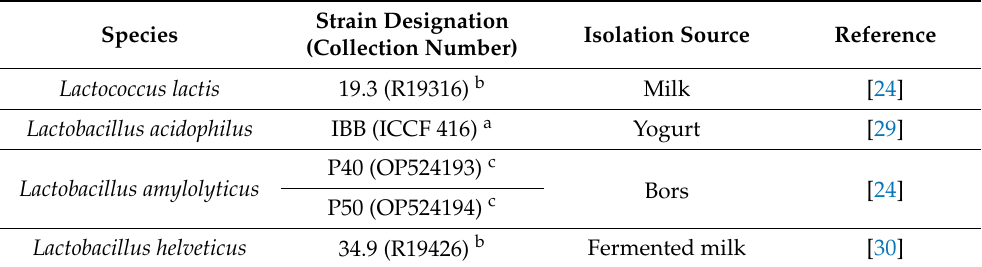
Table 1. Functional LAB strains used in this